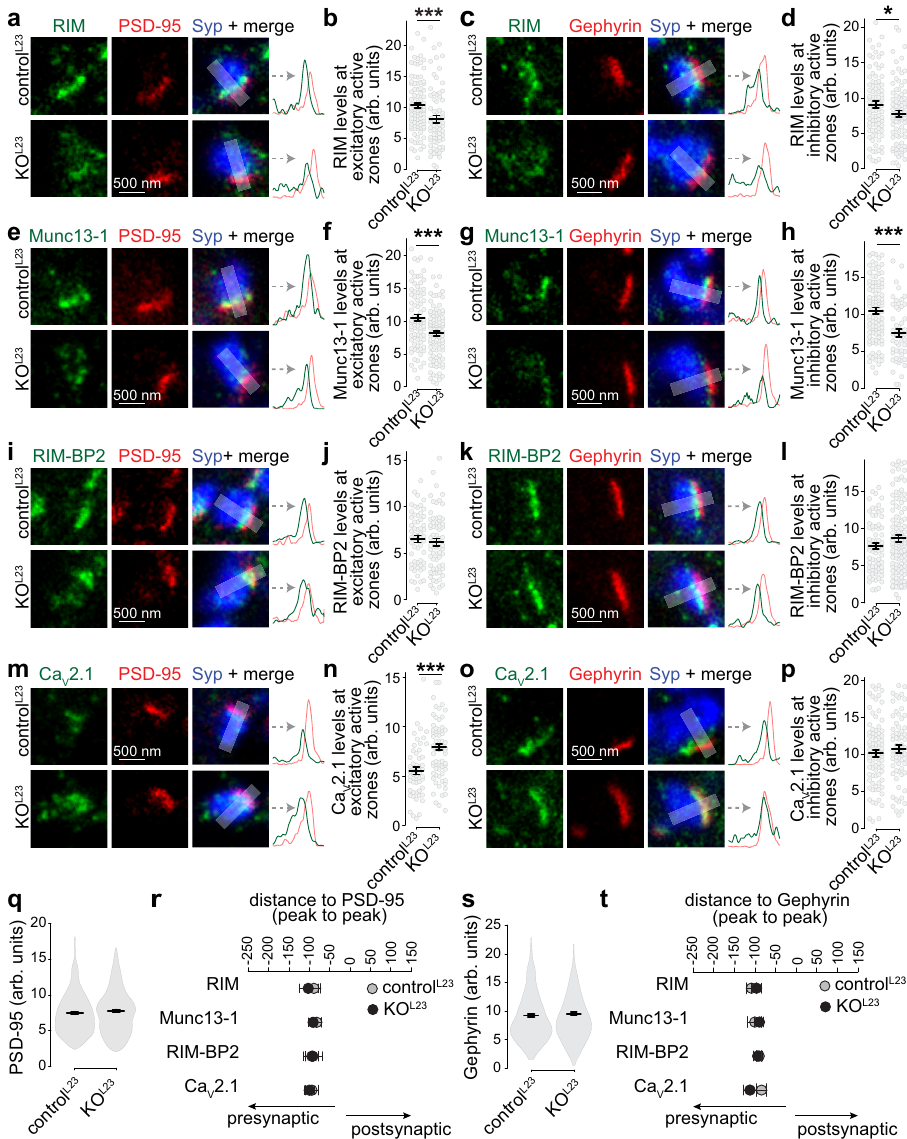
Fig. 5 Active zone composition at excitatory and inhibitory synapses after Liprin- α 2/ α 3 knockout. a – d Example STED images and line pro fi les ( a , c ) and quanti fi cation of peak intensities ( b , d ) of RIM at Synaptophysin (Syp) positive excitatory side-view synapses identi fi ed by PSD-95 ( a , b ) or inhibitory side- view synapses identi fi ed by Gephyrin ( c , d ), b : control L23 : N = 96 synapses/3 independent cultures, KO L23 : N = 69/3, d : N = 91/3, KO L23 : N = 87/3,